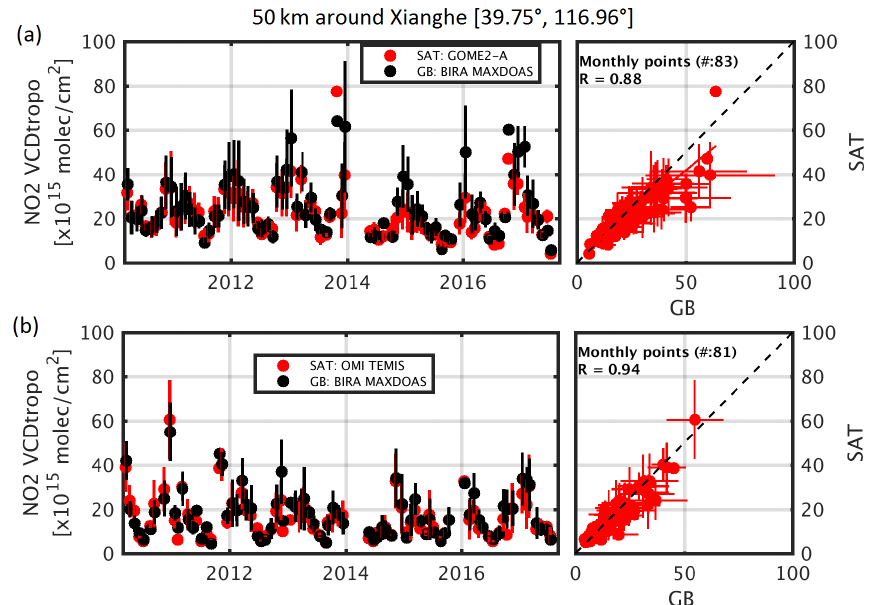
Figure 2. Comparison of monthly mean tropospheric NO 2 VCDs at the Xianghe station for (a) GOME-2A GDP 4.8 data and (b) OMI DOMINO v2.0 versus MAX-DOAS data, over the period March 2010 to July 2017. Correlation coefficients R are given as an inset in the scatterplots on the right column. The variability (standard deviation of the monthly mean) is given as error bars for both